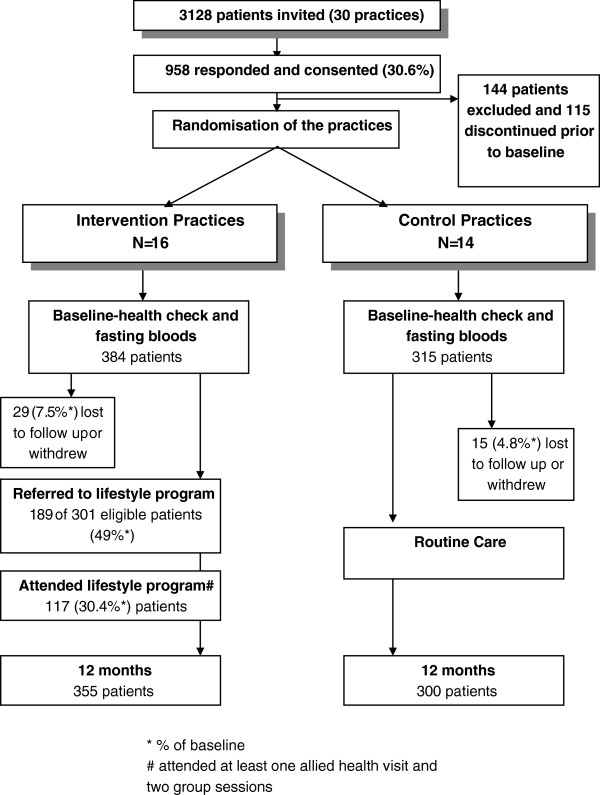
Participant recruitment, flow and follow-up.